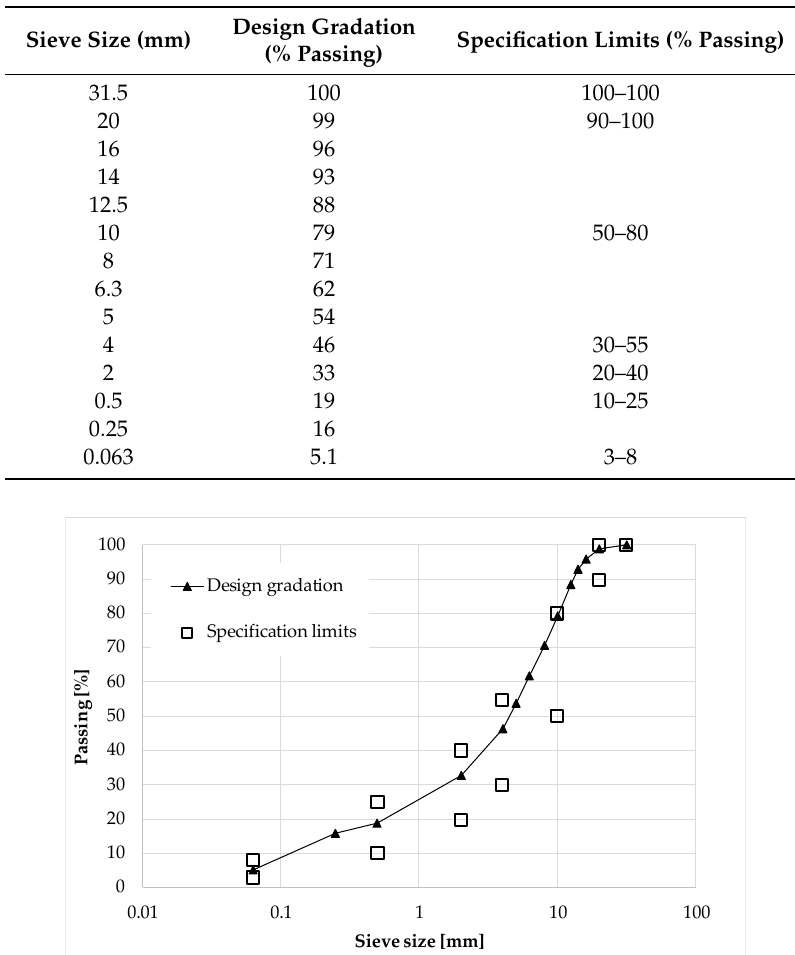
Table 6. Design gradation and specification limits.